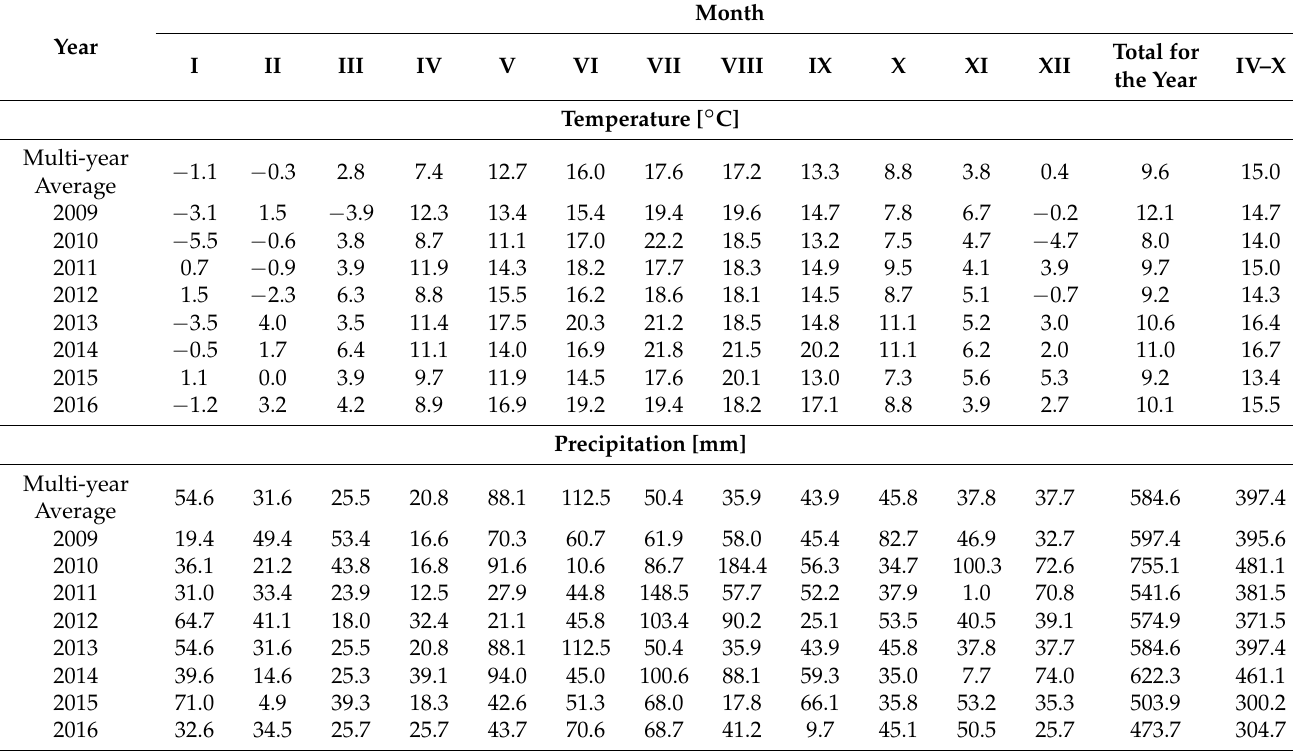
Table 2. Average monthly air temperature and monthly total rainfall in the years 2009–2016.